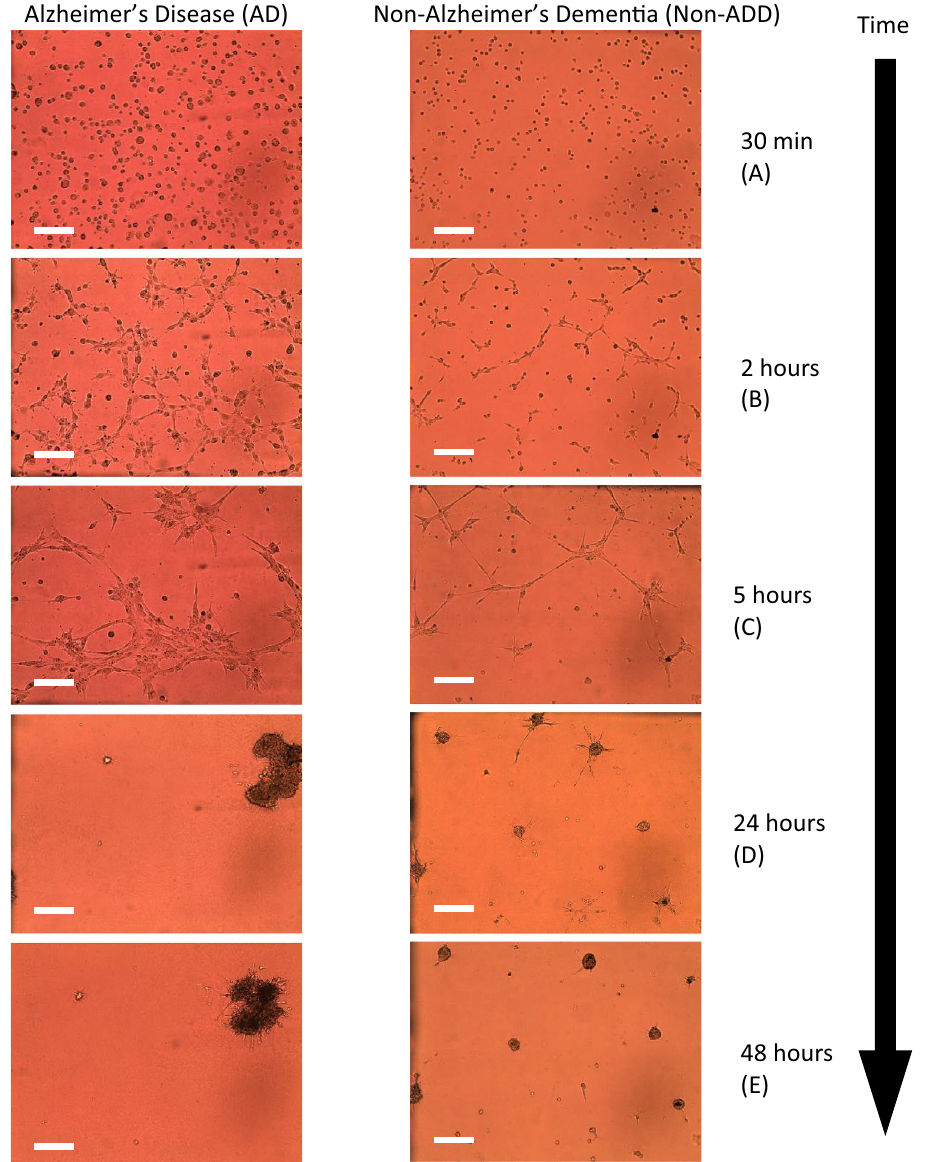
Figure 1. Time course study of cultured skin fibroblasts obtained from Alzheimer’s and non-Alzheimer’s disease (AD/non-ADD) patients on a 3-D Matrigel matrix. AD and non-ADD dementia cells are cultured, and images are taken at 30 min ( A ), 2-h ( B ), 5-h ( C ), 24-h ( D ), and 48-h ( E ) intervals. All images are taken in 10X objective. The scale bar is 250